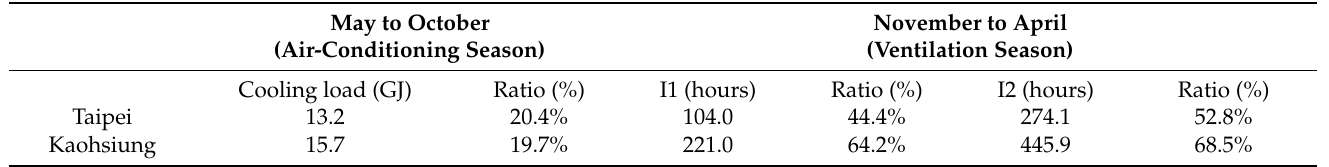
Table 2. The contribution of heat transferred from the roof to the cooling loads and thermal discomfort levels of classrooms without PCM in the roof